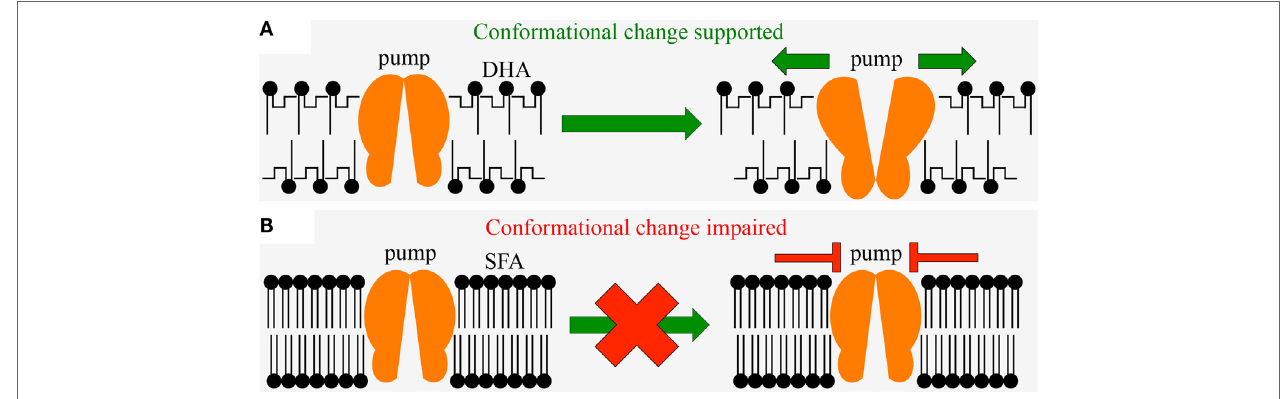
FiguRe 2 | Diagram showing the effect of the fatty acid composition of membrane phospholipids on the fluidity of biological membranes . Membranes need to be fluid enough to allow the sodium–potassium pump (orange) to undergo shape changes (conformational changes) underlying the pump’s ability to generate the chemical and electrical potential across the membrane required for nerve impulses as critical functions of the brain and the heart muscle. (a) sufficient availability of the polyunsaturated fatty acid DHA (with highly bent fatty acid tails that result in loose, fluid membranes) in the diet is required to support the pump’s conformational change; (b) excessive consumption of saturated fat with its straight, rigid fatty acid tails (SFA) that result in tightly packed membranes, impairs ability of the pump to undergo conformational change. Since polyunsaturated fatty acids are vulnerable to oxidation, sufficient levels of antioxidants are required to maintain the integrity of DHA and its function in nerve impulses. DHA, docosahexaenoic acid (a polyunsaturated omega-3 fatty acid); SFA, saturated fatty